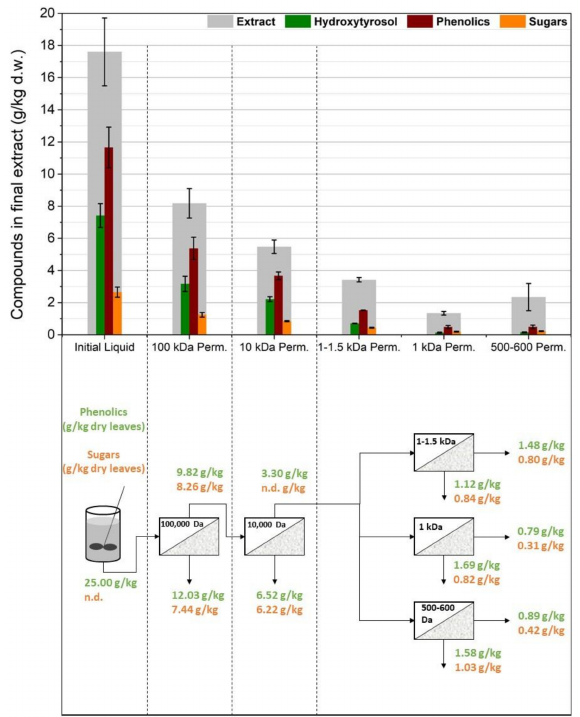
Figure 3. The first membrane treatment scheme: two ultrafiltration steps (US100, UP010) were used in line and the permeate from the 10,000 Da membrane was split into three equal parts and treated using three different nanofiltration membranes (NP010, UA60,